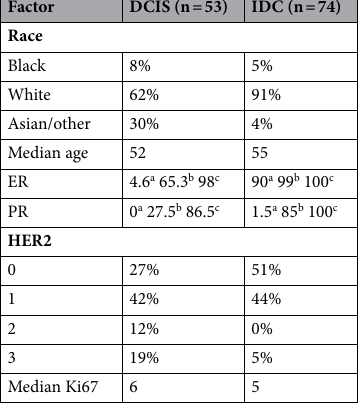
Table 1. Clinical features for DCIS and IDC patient samples from the Biospecimen Core Repository Facility. Percent of total are shown with actual number of cases in parentheses. a 25% percentile, b median, c 75th percentile are shown for Estrogen Receptor (ER) and Progesterone Receptor